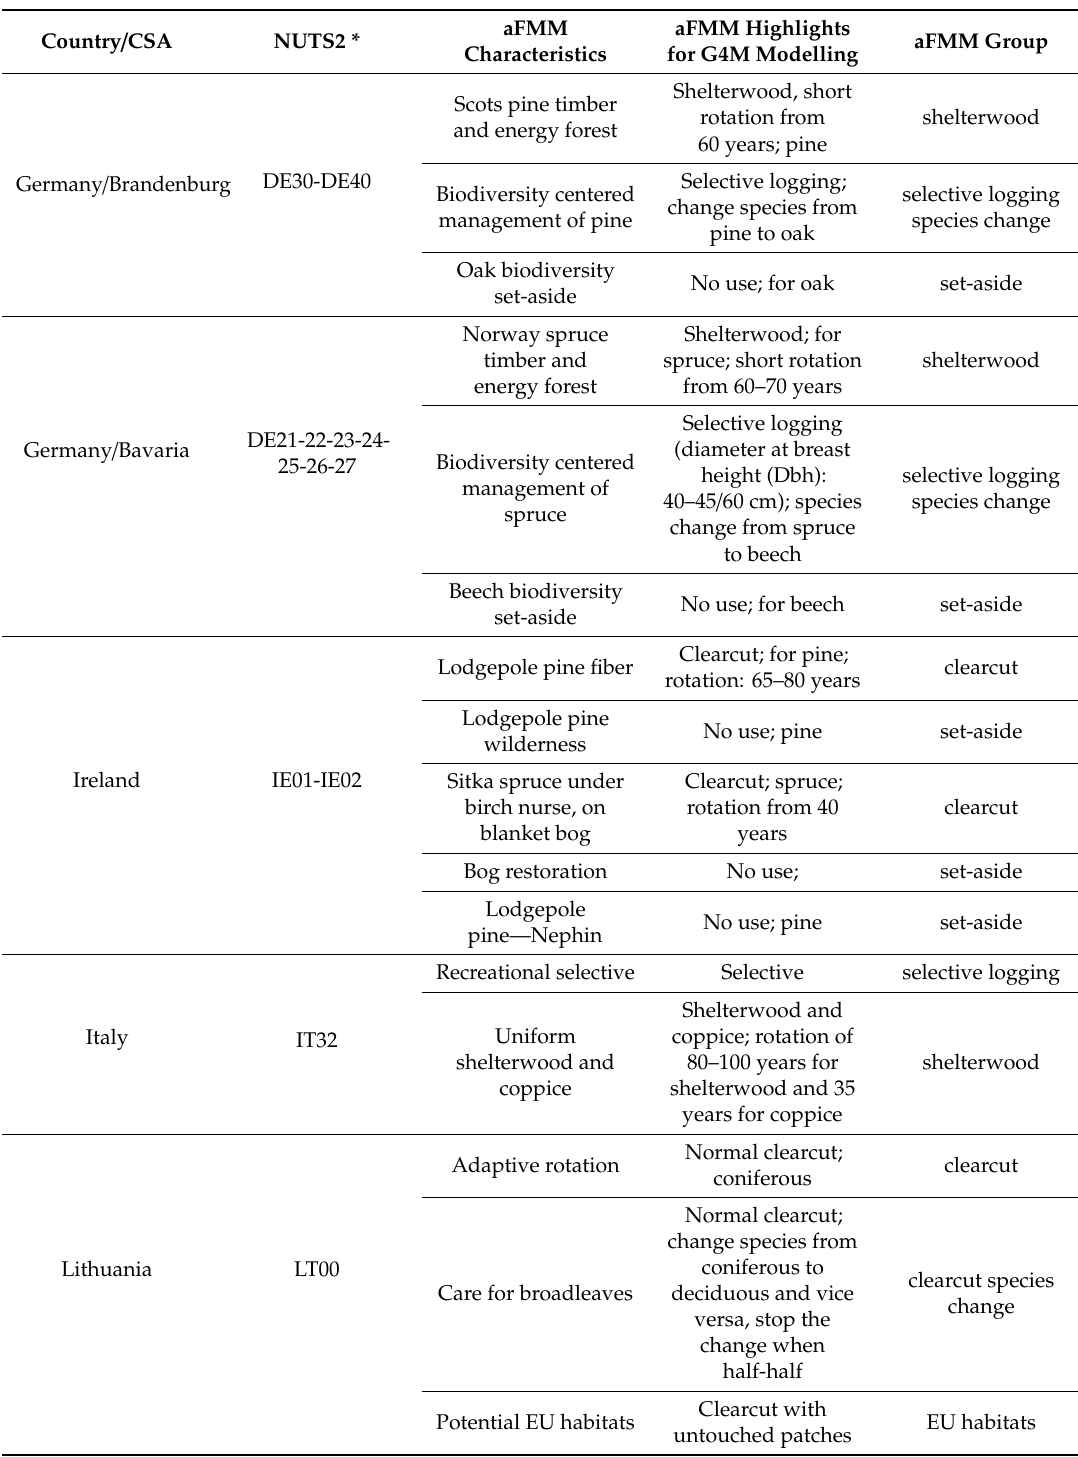
Table 1. Description of selected alternative forest management models (aFMMs) in the ALTERFOR case study areas (CSA) and their grouping for further modeling in the Global Forest Model